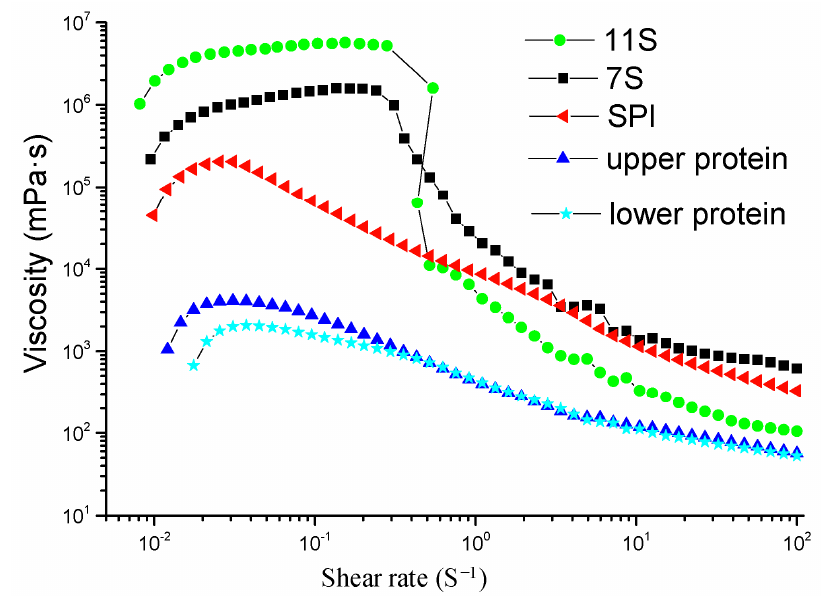
Figure 3. Rheological properties of the film solution of SPI and fractioned products.